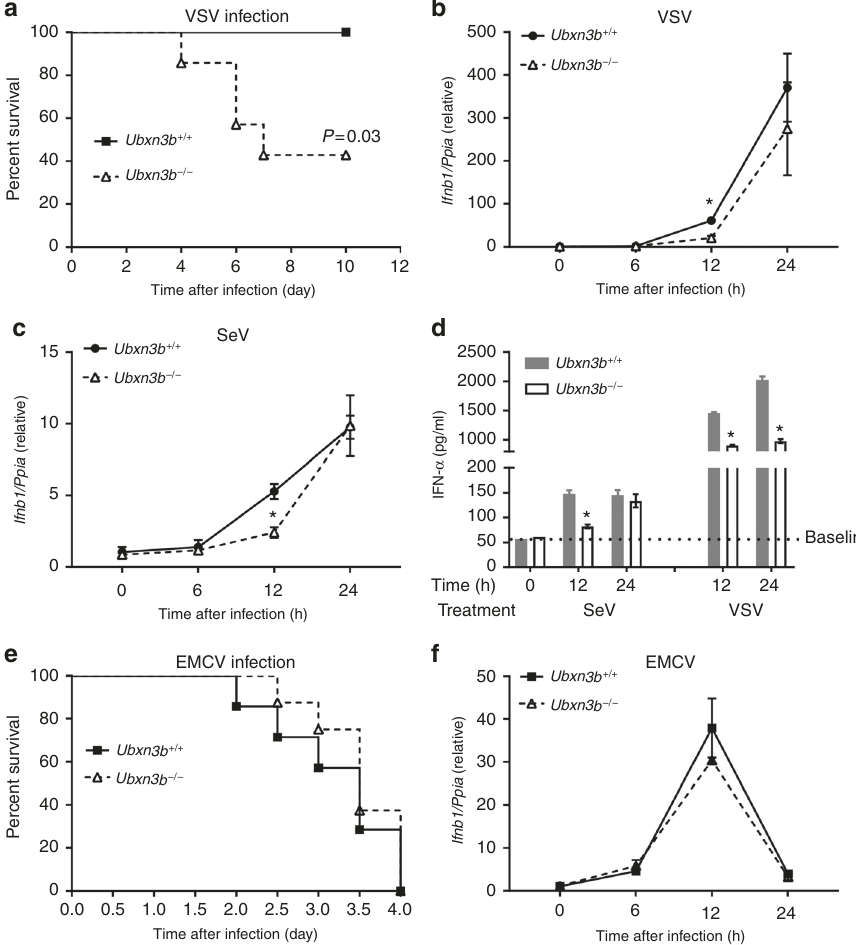
Fig. 3 UBXN3B is critical for type I IFN responses to SeV and VSV, but not EMCV infection. a The survival curves of Ubx3b − / − ( N = 6) and Ubxn3b − / − ( N = 7) mice infected with 1 × 10 7 PFU of VSV i.v. The results are pooled from two experiments. * P < 0.05 (log-rank test). b , c qPCR analysis of Ifnb1 expression in cDCs infected with b VSV (MOI = 5) or c SeV (200 hemagglutination units per 10 5 cells). d ELISA of IFN- α in the cell culture supernatants of cDCs infected with SeV and VSV as in b , c . N = 3 per genotype per time point. * P < 0.05 (unpaired Student ’ s t test). e The survival curves of Ubx3b + / + ( N = 7) and Ubxn3b − / − ( N = 8) mice infected with 200 PFU of EMCV i.p. P = 0.53 (log-rank test). The results are pooled from two experiments. f qPCR analysis of Ifnb1 expression in cDCs infected with EMCV (MOI = 5) for the indicated time. Bars/data points: mean ± s.e.m. Two biological replicates were pooled for qPCR ( N = 2 per genotype per time point). * P < 0.05 (unpaired Student ’ s t test). The results are representative of two independent experiments